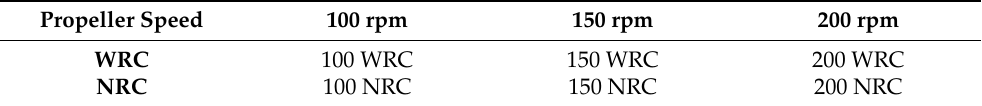
Figure 12. Velocity magnitude along ( a ) y/R=1.25 and ( b ) x/R = 1.25 in the